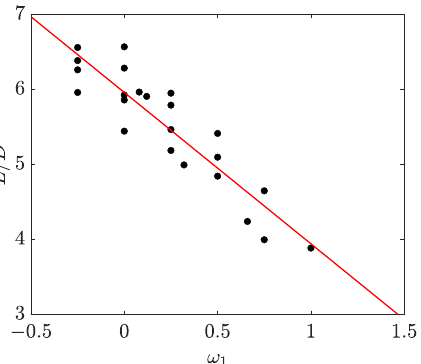
Figure 10. Correlation between L / D and ω 1 . The black dots show the lift-to-drag ratio of the 19 design points at the design of experiment and four test data sets. The red line shows the linear regression model computed with data from the 23 simulations. The R-squared value of this regression model is R 2 = 0.822, representing a moderate correlation between ω 1 and L / D